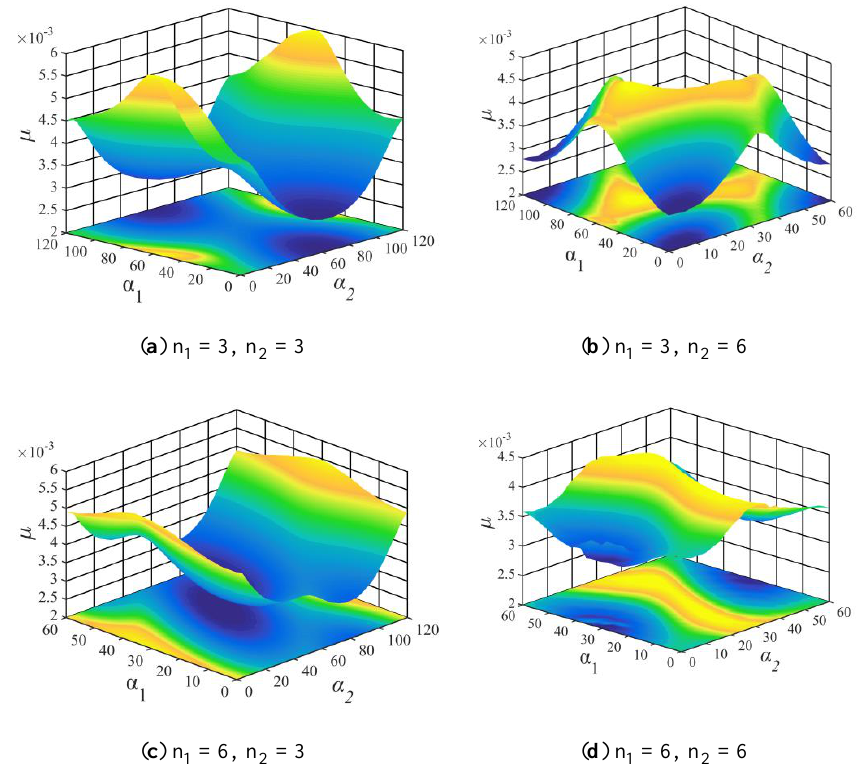
Figure 9. Variations of µ with the wave phase angle under four cases.